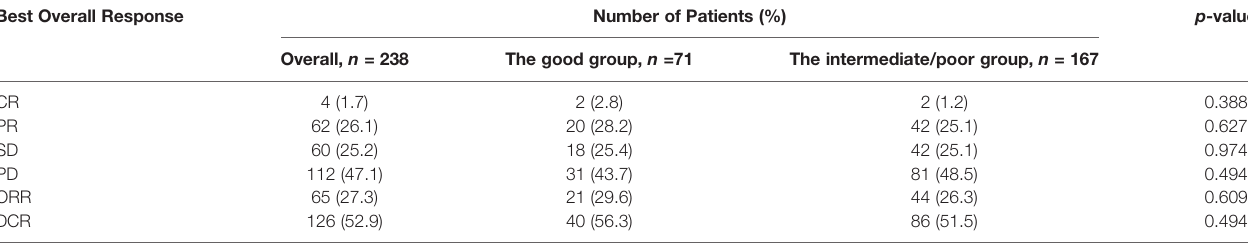
TABLE 2 | Relationship between the good group and the intermediate/poor group and response to ICIs